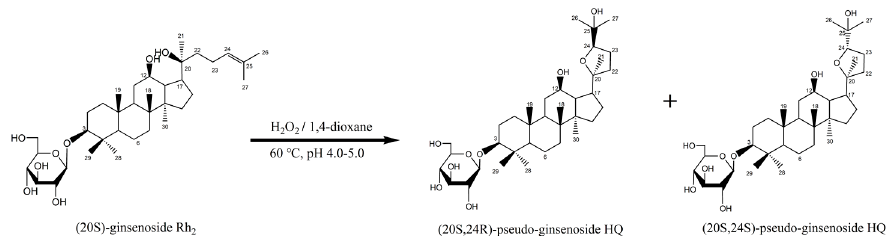
Figure 5. Synthesis process of R -PHQ and S -PHQ. Rh 2 was dissolved in 1,4-dioxane at the pH of 4.0–5.0; afterward, hydrogen peroxide was added and the reaction solution was heated at 60 ◦ C to produce the two cyclization products— R -PHQ and S -PHQ.